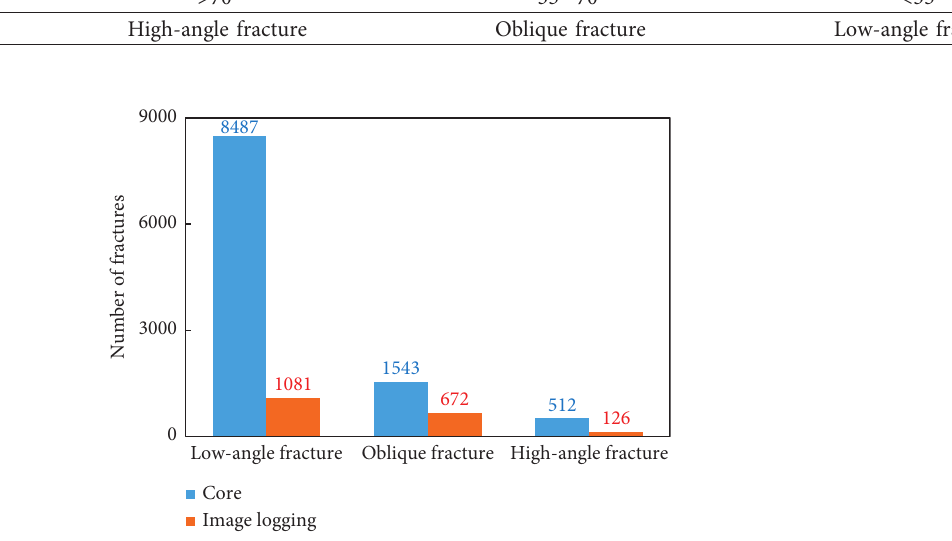
Figure 2: Numbers of the fractures with different types. Table 2: Fracture opening size and fracture